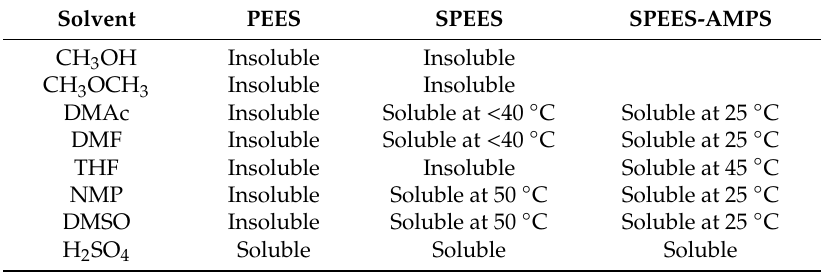
Table 2. Solubility data .